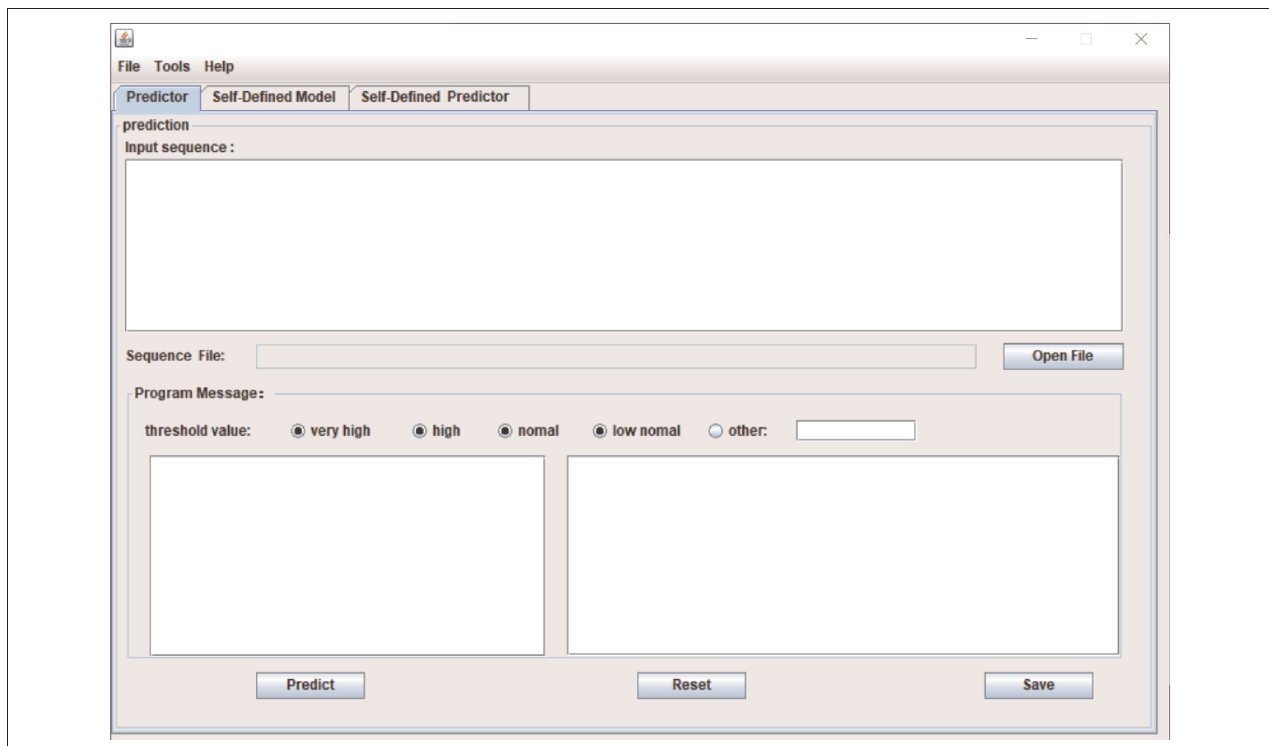
FIGURE 8 | The Java interface implementation of PEA-m5C.